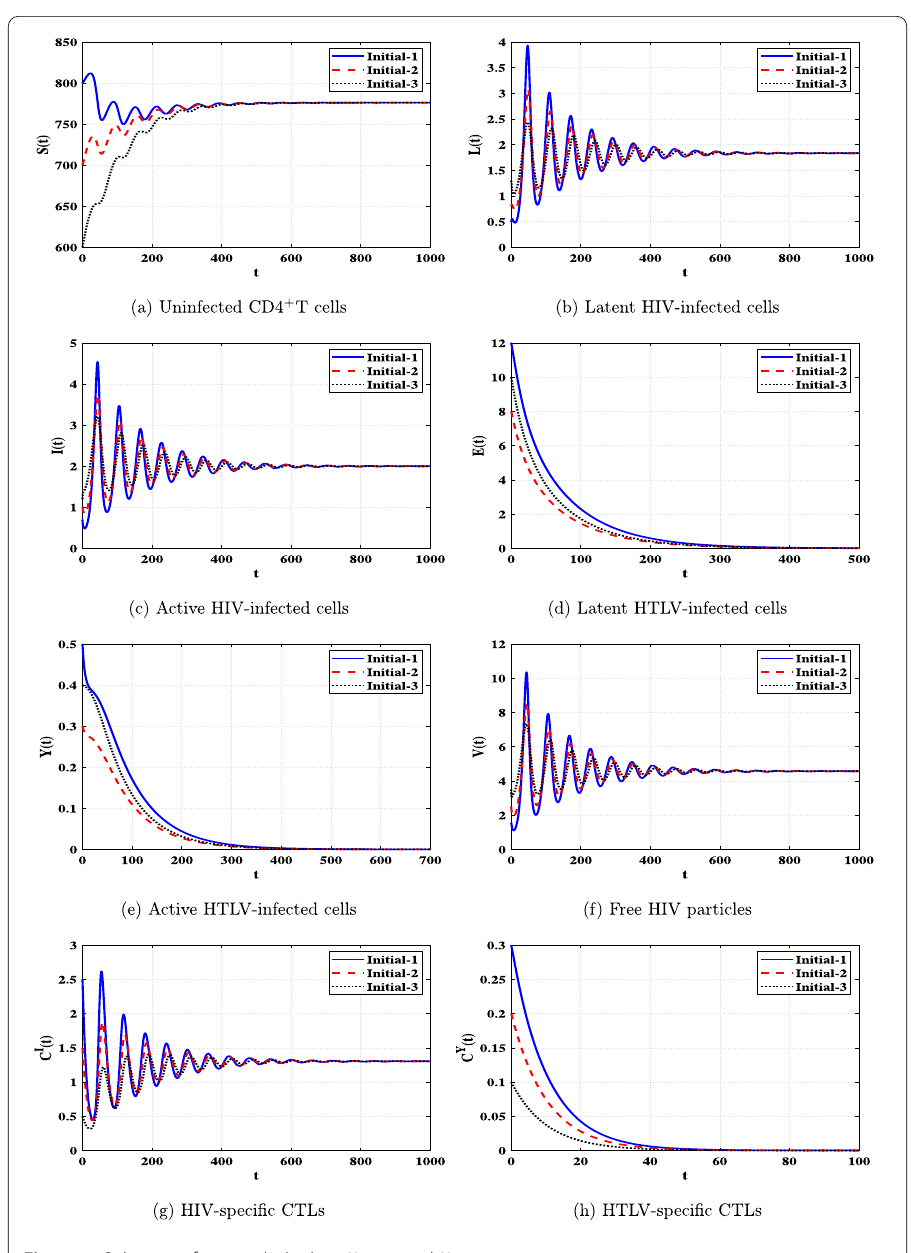
Figure 4 Solutions of system (29) when (cid:9) 3 > 1 and (cid:9) 5 ≤ 1